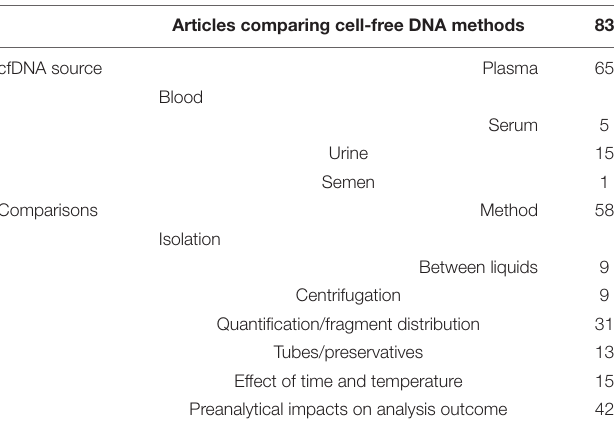
TABLE 5 | Investigated parameters within the publications assessing the impact of various preanalytical and analytical parameters of cfDNA research. Articles comparing cell-free DNA methods 83 cfDNA source